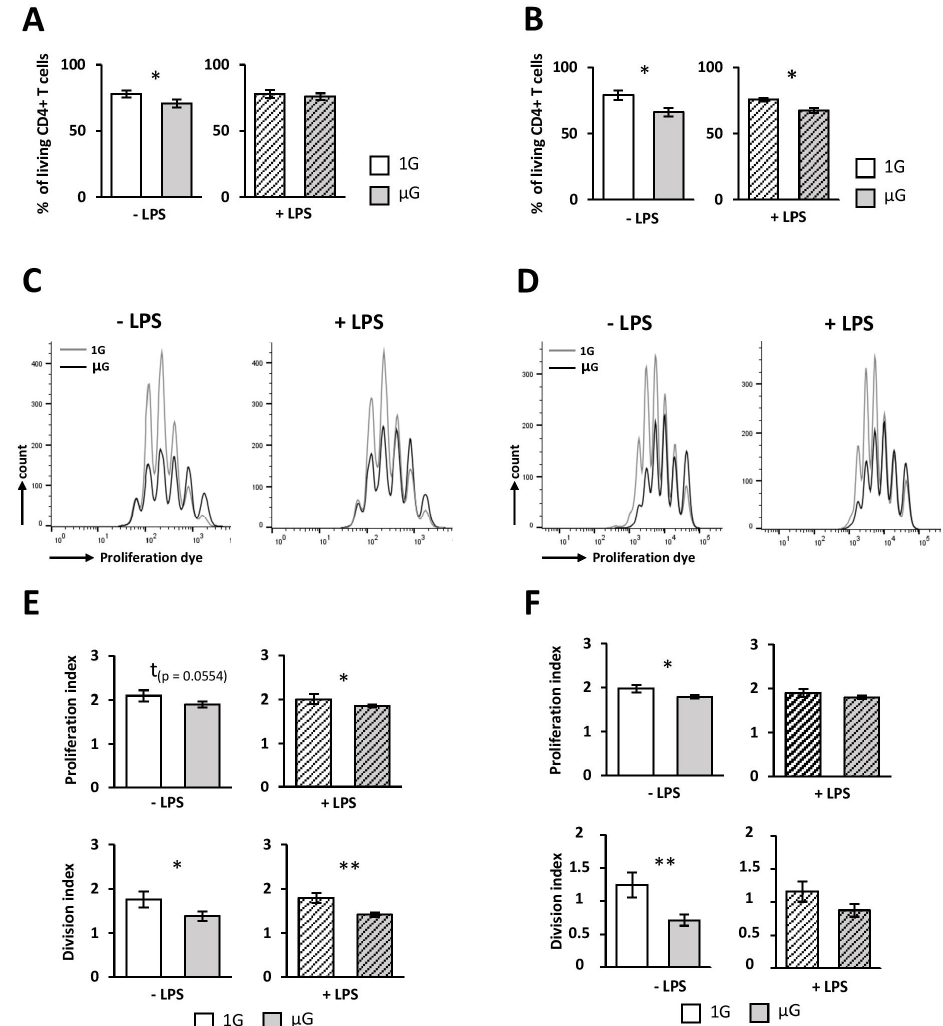
Figure 5. Simulated microgravity impairs DCs’ ability to stimulate CD4+ T cell proliferation and survival. Splenic DCs were cultured for 24 h in the absence (1G) or presence ( µ G) of simulated microgravity with (+LPS) or without ( − LPS) LPS and then pulsed with ovalbumin peptide (ova 323-339 ) ( A , C , E ) or full protein ( B , D , F ). DCs were then co-cultured for 3 days with mouse-isolated OTII CD4+ T cells. Cell survival ( A , B ) and proliferation ( C – F ) were assessed using flow cytometry by using dead cell or proliferation tracker, respectively. ( A , B ) Mean percent ± SEM of living CD4+ T cells. ( C , D ) Representative proliferation profile from at least 3 independent experiments with the same results. ( E , F ) Mean ± SEM of proliferation and division indexes calculated using FlowJo software v10.8.1 for three ( E ) or four ( F ) independent experiments. T-test or Mann–Whitney test was used to reveal statistically significant differences. * p < 0.05, ** p < 0.01, t indicates a tendency. The reduced proliferation and division indices, compared to control conditions, demon- strated that CD4 T-cell proliferation was impaired when CD4 T cells were activated with DCs exposed for 24 h to microgravity, consistent with cell survival (Figure 5C–F). Indeed, CD4 T-cell proliferation and division indices were reduced by approximately 10% and 20%, respectively, when non-activated or LPS-activated ova 323-339- pulsed DCs were used to stimulate CD4 T cells in the µ G, compared to the 1G condition (Figure 5C,E). These results Th1 cells was less effective, a reduced percentage of about 25% of Th1 cells was obtained showed that less CD4 T cells can proliferate and those that enter into division proliferate less. Comparable results were obtained under the µ G condition using full-length ovalbu- min to pulse DCs with proliferation and division indices reduced by approximately 10% and 40%, respectively, compared to the 1G condition (Figure 5D,F). Under these